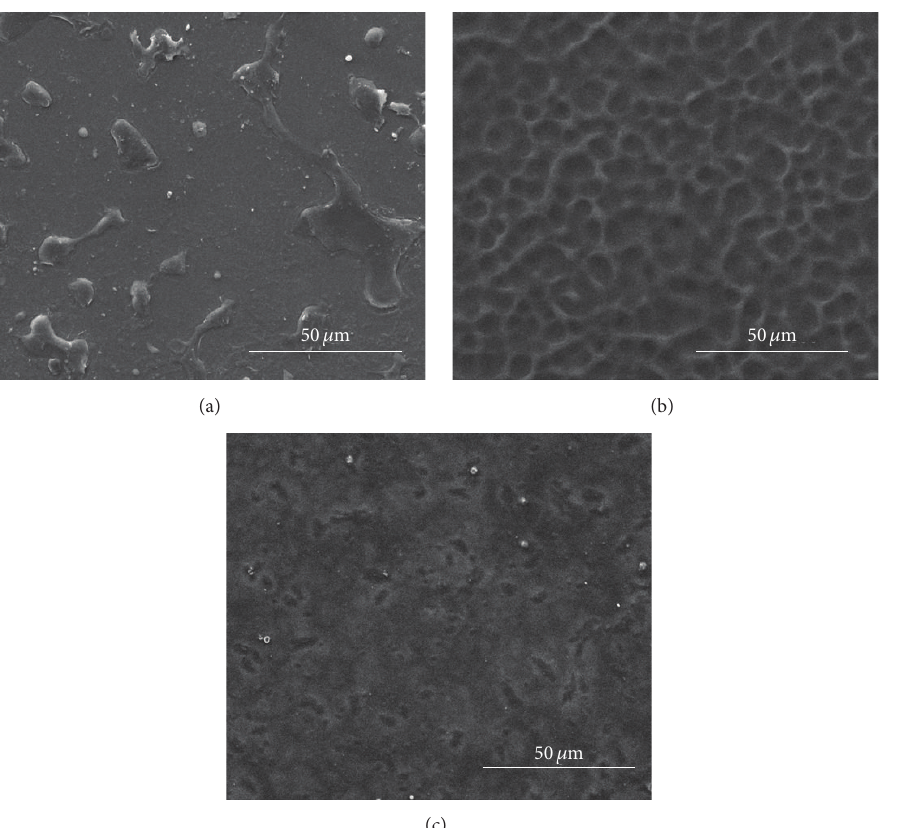
Figure 2: SEM images of PEDOT:PSS film: (a) original PEDOT:PSS dispersion, (b) IPA-diluted solution ((PEDOT:PSS): IPA = 1: 14), and (c) IPA-diluted solution ((PEDOT:PSS): IPA = 1: 14) doped with 1% Zonyl FS-300 fluorosurfactant. All PEDOT:PSS films were deposited under the same temperature at 130 ∘ C with a N 2 flow rate of 10L/min.